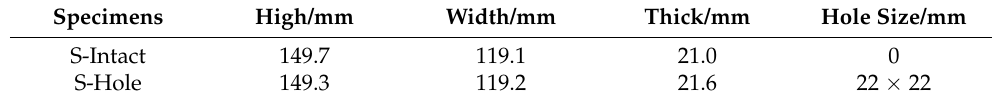
Table 1. The size of specimen and hole.